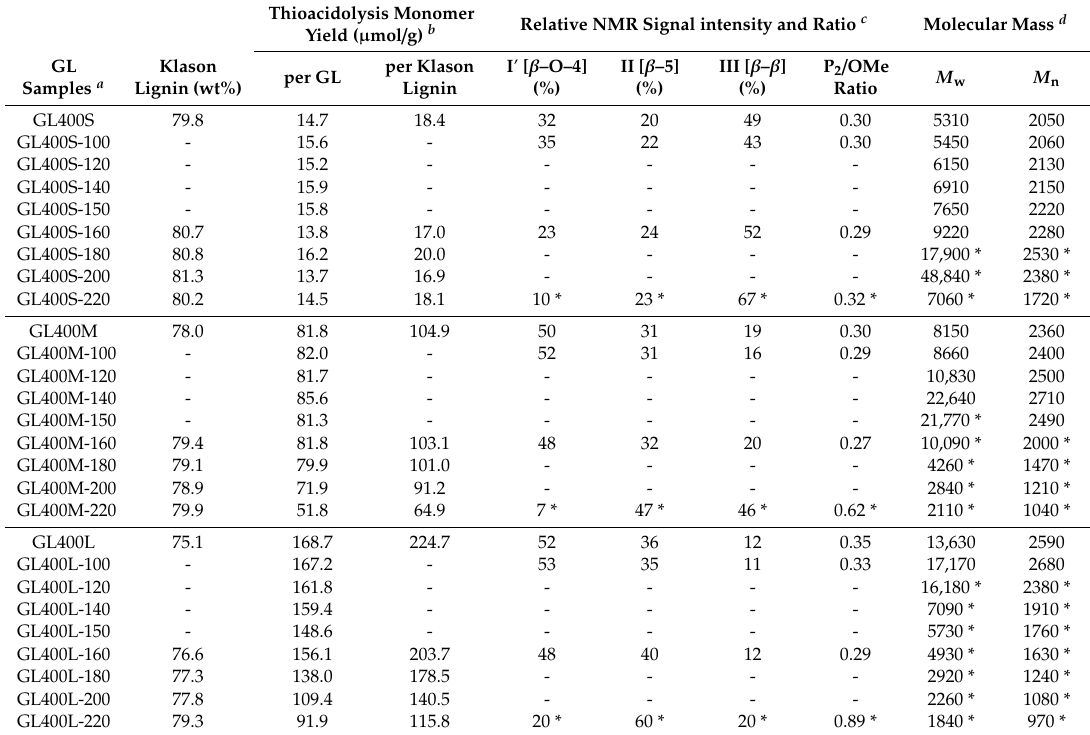
Table 1. Chemical structure and molecular mass data for heat-treated GL400